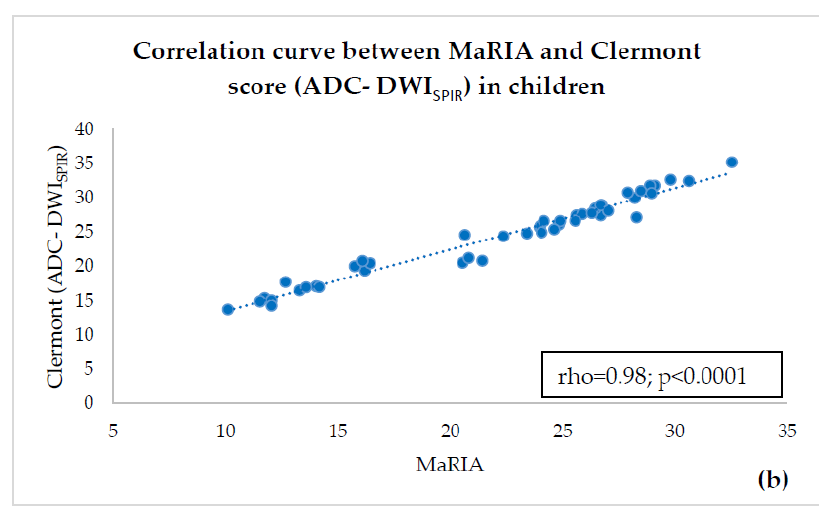
Figure 4. Correlation curve between MaRIA and ADC-DWI SPIR —based Clermont score in adults ( a ) and children ( b ) showing high correlation.